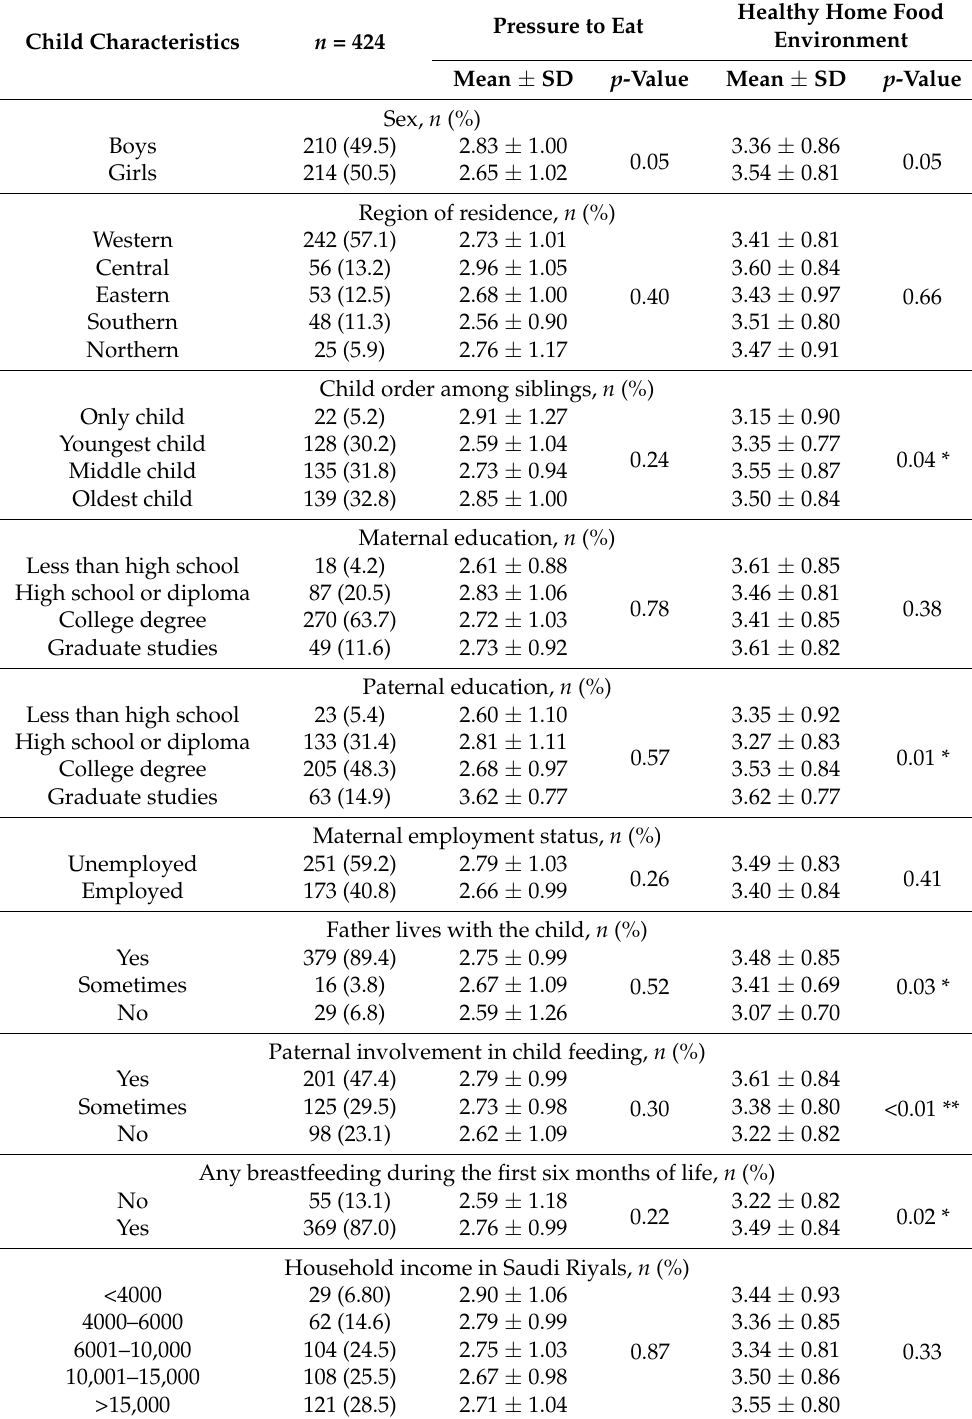
Table 1. Child characteristics and associations a with maternal feeding